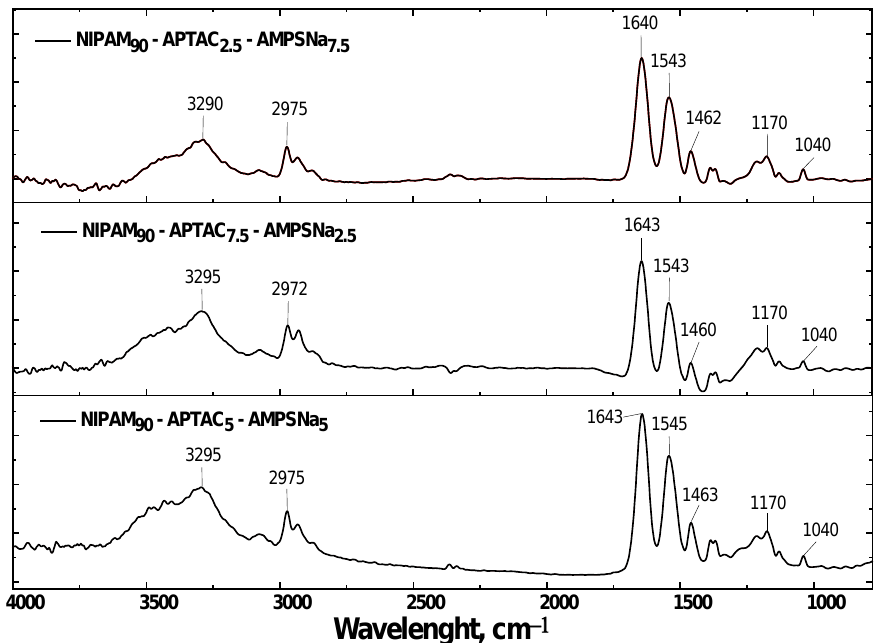
Figure 2. FTIR spectra of nanogels based on NIPAM-APTAC-AMPS. SEM data show that nanogel particles have glued or stuck aggregates connected by narrow necks and voids of nanometer and micron size (Figure 3). Due to multiple contacts between spherical or wormlike nanogels, macroscopic gelation occurs, leading to the formation of three-dimensional networks of nanogels